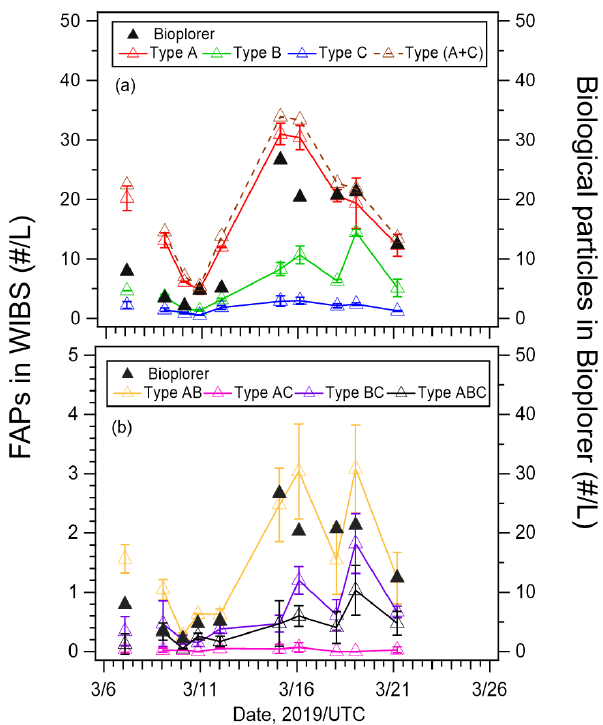
Figure 4. Time series of (a) number concentrations of all particles (black line) and fluorescent aerosol particles (FAPs, red line), as well as number fractions of FAPs (blue marker); (b) relative frac- tions of types; and (c) number concentrations of type A, B, and C (second axis) particles and wind speed (dashed line). Time series of (d) size-resolved number concentrations of ambient particles and (e) the ratio of the number concentration of particles larger than 2µm to number concentration of particles smaller than 2µm.